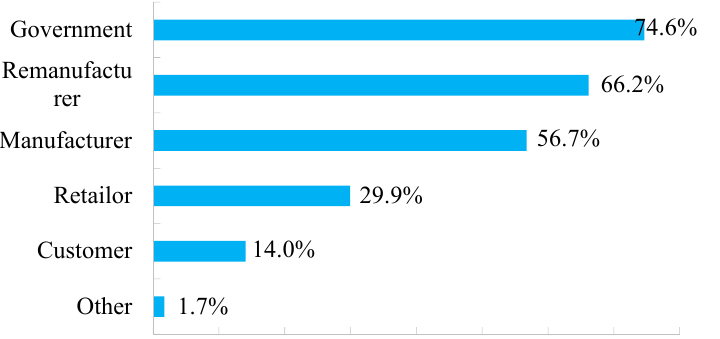
Figure 5. Responsible entities for promoting remanufactured products.